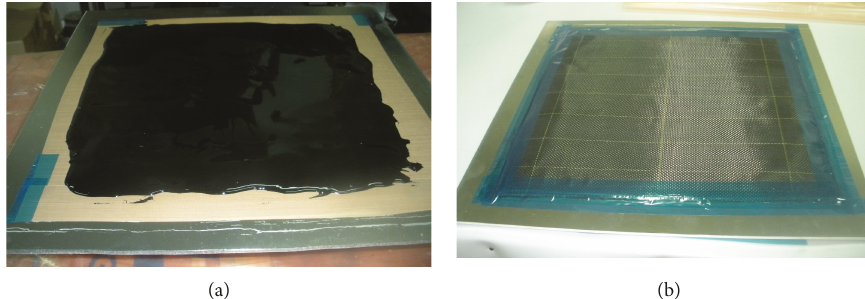
Figure 6: (a) Resin thick fi lm distribution and (b) preform on the thick resin fi